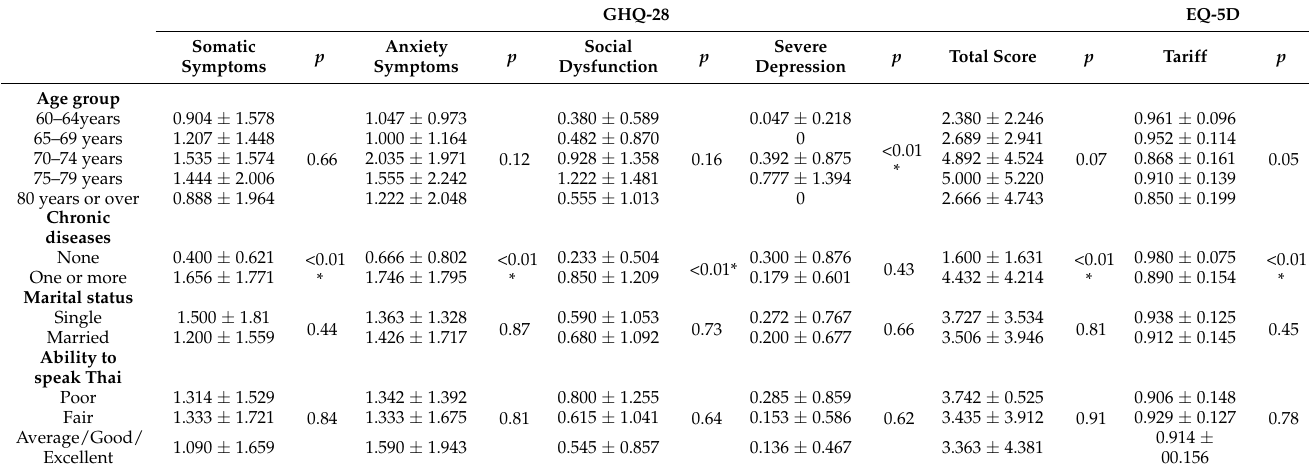
Table 2. Scores for each item in the GHQ-28 and EQ-5D by age, chronic diseases, and mental health status.